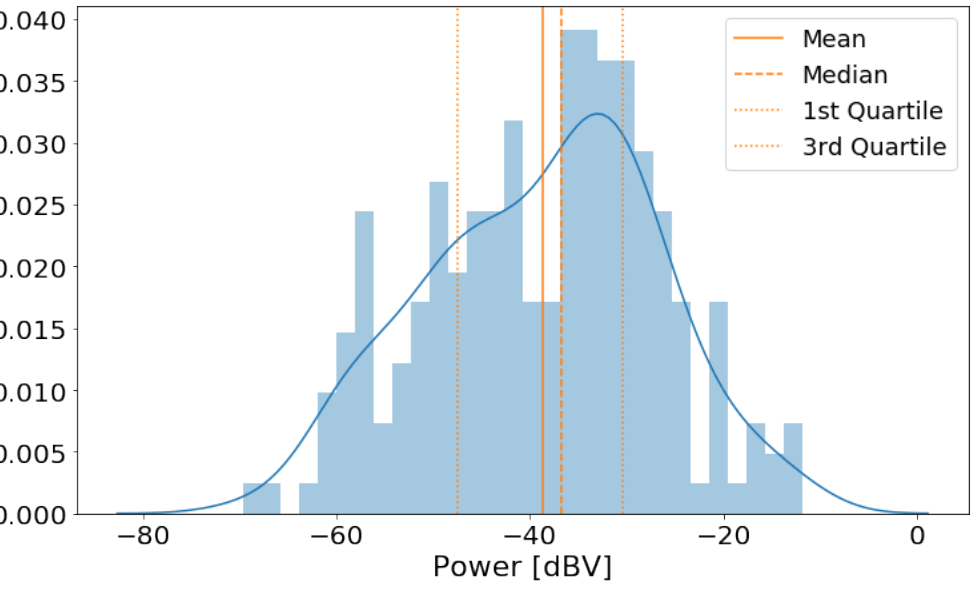
Figure 4. Histogram of measured noise power levels.